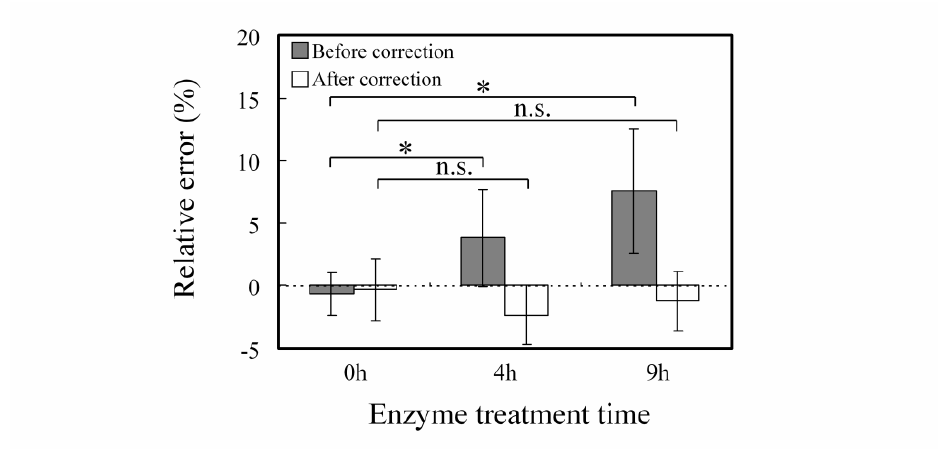
Fig. 6 Changes in error of thickness measurement before/after correction Mean values (SD) are shown for the 0 h (n=10), 4 h (n=10), and 9 h (n=10) groups. *Significant difference by Student’s t-test